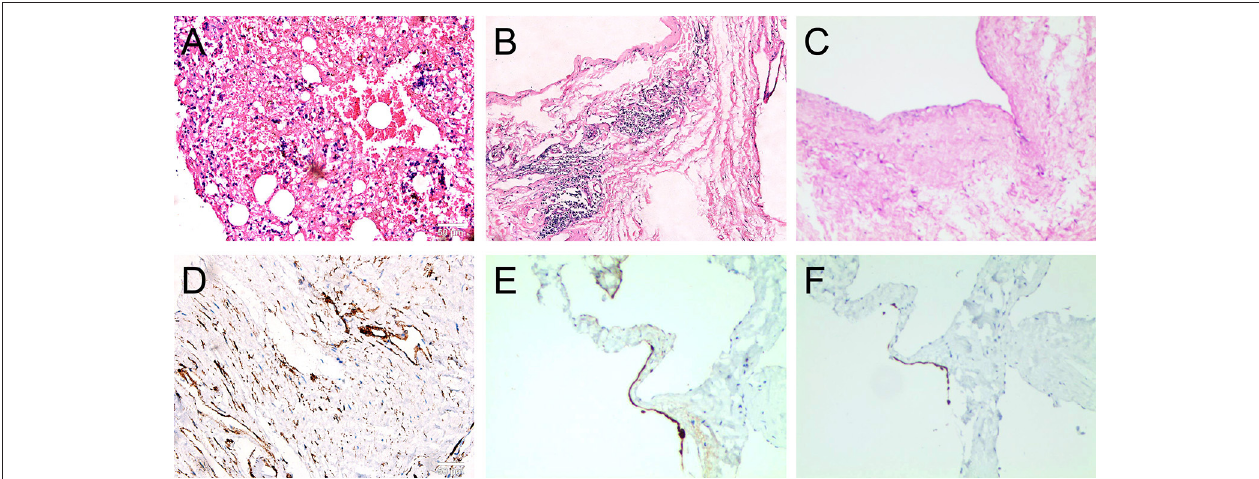
FIGURE 3 | Post-operative histological examination with hematoxylin-eosin staining showing the proliferation of fibrous tissue in cyst wall (A) ; hyalinosis (B,C) , lymphocyte infiltration (B,C) ; and the immuohistochemical staining showing the positive expression of Ki-67, Vim, SMA, MC, and partial positive of D2-40 (D) , CK5/6 (E) , CR (F) , CD34, CD31, and WT-1, but negative of CK, EMA, MOC31, and Des (100X, scale bar = 50 µ m).